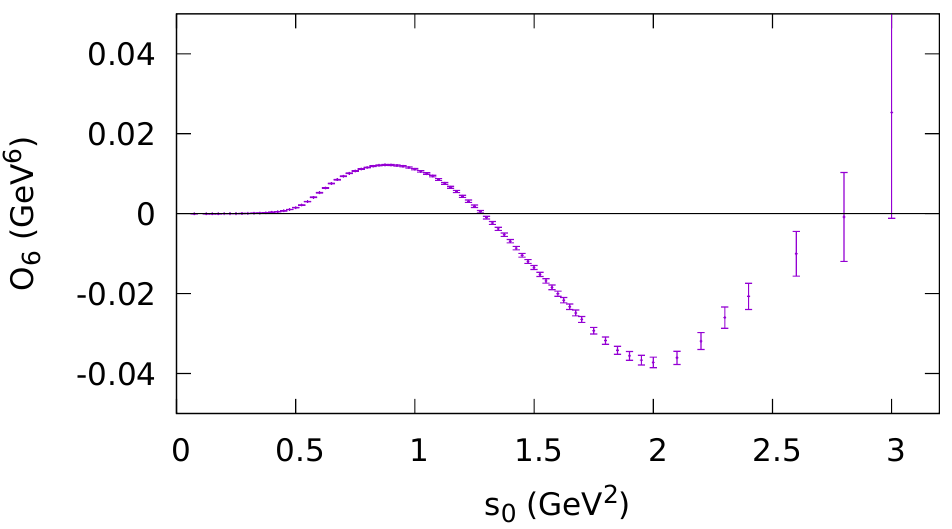
Figure 4 . Rescaled version of the moment associated to ω ( s ) = ( s/s 0 ) 2 so that, at large-enough s 0 , it converges to hO 6 i .